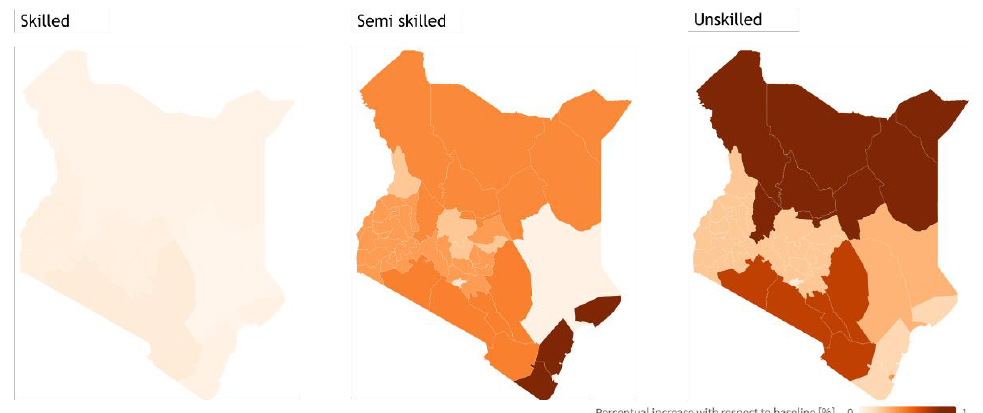
Figure 6. Labor demand induced by all the $100m mix of interventions by skill level and region.